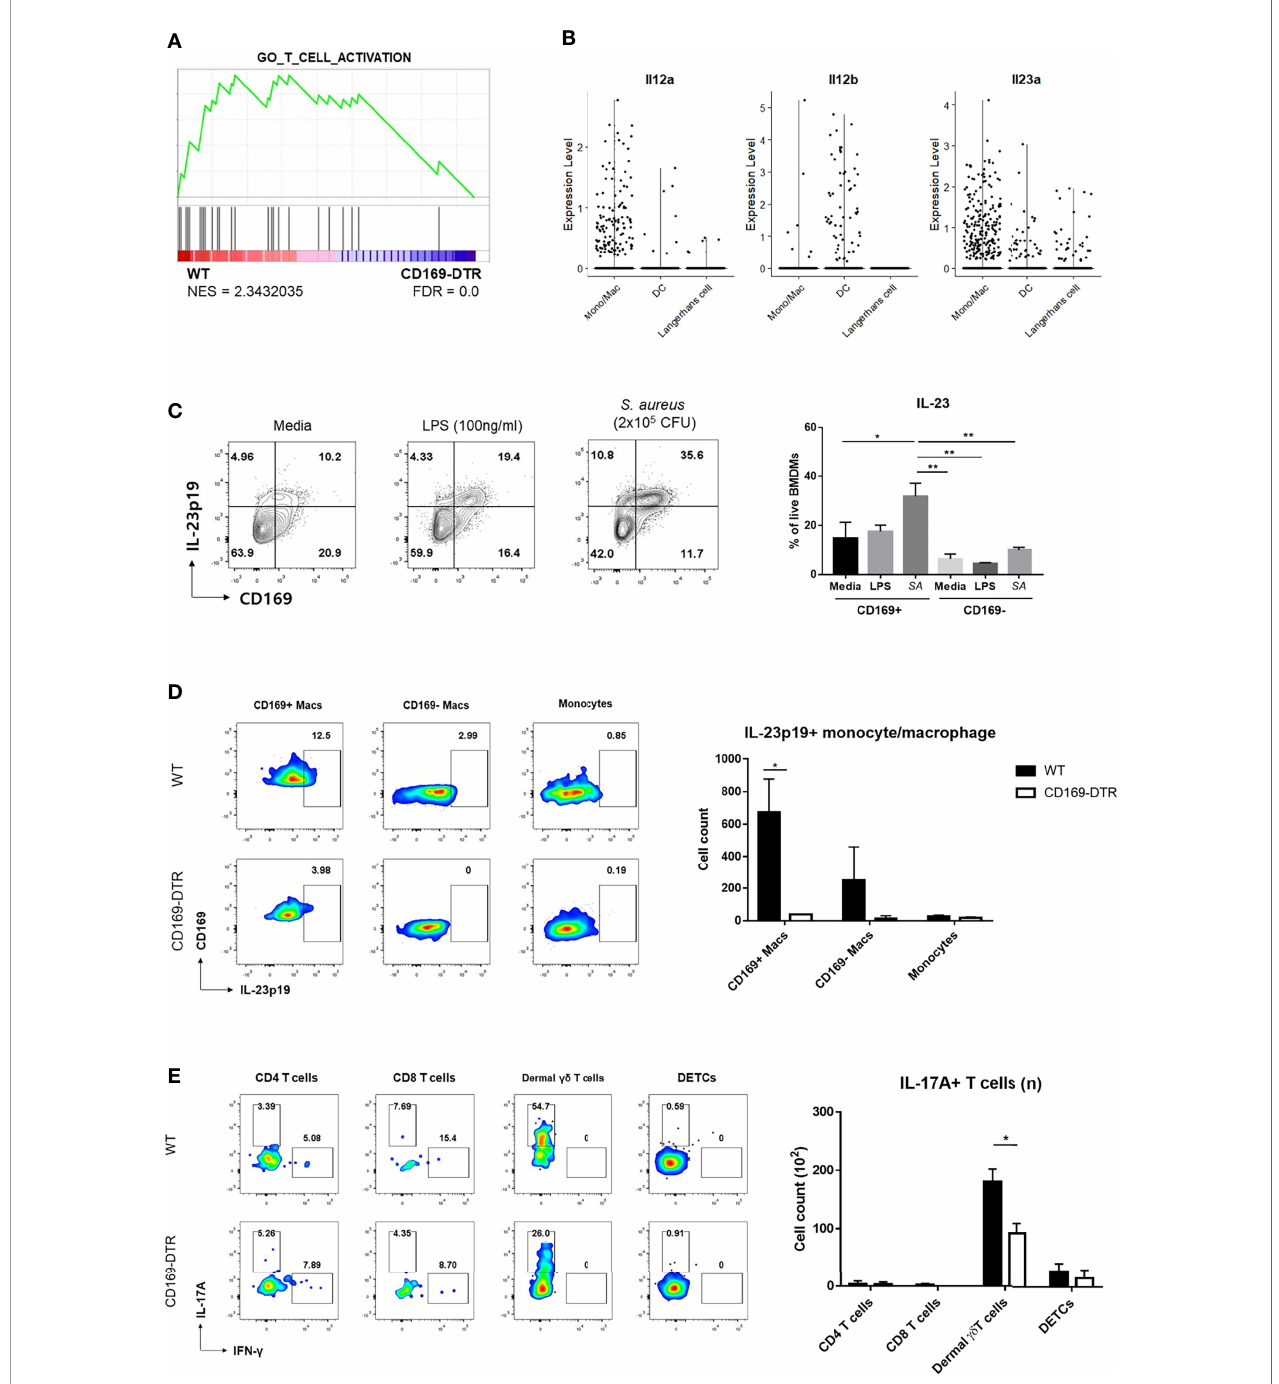
FIGURE 6 | Activation of gd T cells by CD169+ macrophages. (A) GSEA of DEGs from dermal gd T cells of WT mice compared to CD169-DTR mice. (B) Violin plots of Il12a, Il12b, and Il23a expression in monocyte/macrophage, dendritic cell (DCs) and Langerhans cell clusters from scRNA-seq analysis data. (C) Representative fl ow cytometry plots and bar graph of BMDMs challenged with LPS (100 ng/mL) and S. aureus (SA, 2x10 5 CFU). (D) Representative plots and bar graph of IL- 23p19 production by CD169 + macrophages (Macs), CD169 - macrophages and monocytes on day 1 post skin S. aureus infection. Single-cell suspensions from two mice were pooled for both WT and CD169-DTR group. CD169 +/- Macs were gated on FSC/SSC, PI - , singlet, CD45.2 + , CD11b + , EpCAM - , Ly6c -tolo , Ly6G - , F4/80 + cells. Monocytes are gated on FSC/SSC, PI - , singlet, CD45.2 + , CD11b + , EpCAM - , Ly6c hi cells. (E) Representative plots and bar graph of IL-17A-producing T cells in skin 6 days post infection. T cells are gated on FSC/SSC, singlet, PI - , CD45.2 + , CD3 + , CD11b -tolo cells. Single-cell suspensions from two mice were pooled for both WT and CD169-DTR group. Data are representative of three independent experiments. Error bars show mean ± SEM (*p < 0.05; **p <